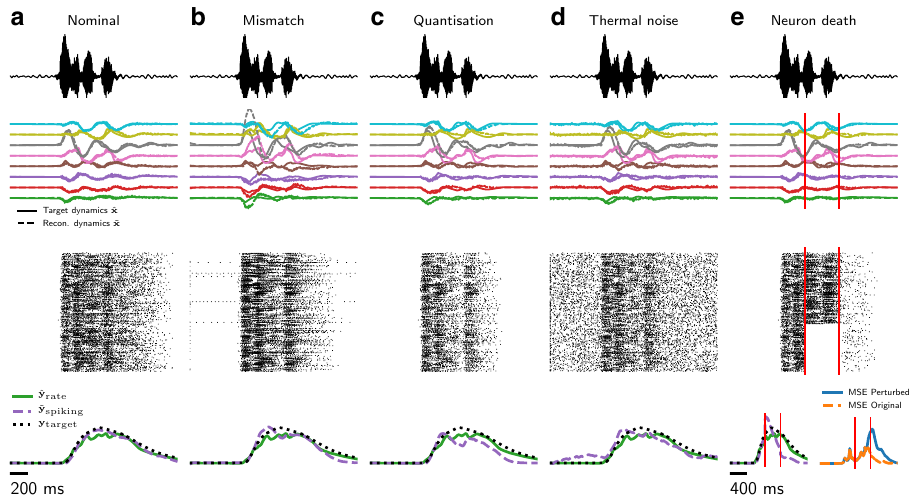
Figure 4. Our trained spiking networks are robust to device mismatch and other sources of noise. Each column shows (top to bottom) the raw signal input; the ANN and reconstructed dynamics; the spiking activity of the ADS network; and the task output and target signals. ( a ) The trained ADS network reproduces the ANN internal and target signals with high accuracy. ( b ) In the presence of simulated mismatch in a mixed-signal silicon implementation of LIF neurons (20%; see “Methods”), the ADS network compensates well for the resulting frozen parameter noise. ( c ) Frozen weight noise introduced by quantisation of weights to 4 bits is compensated by the ADS spiking network. ( d ) The spiking network also compensates well in the presence of simulated thermal noise ( σ = 5% ). ( e ) The balanced fast recurrent feedback connections (cid:31) f permit the ADS spiking network to compensate for sudden neuron death (40% of spiking neurons silenced between vertical